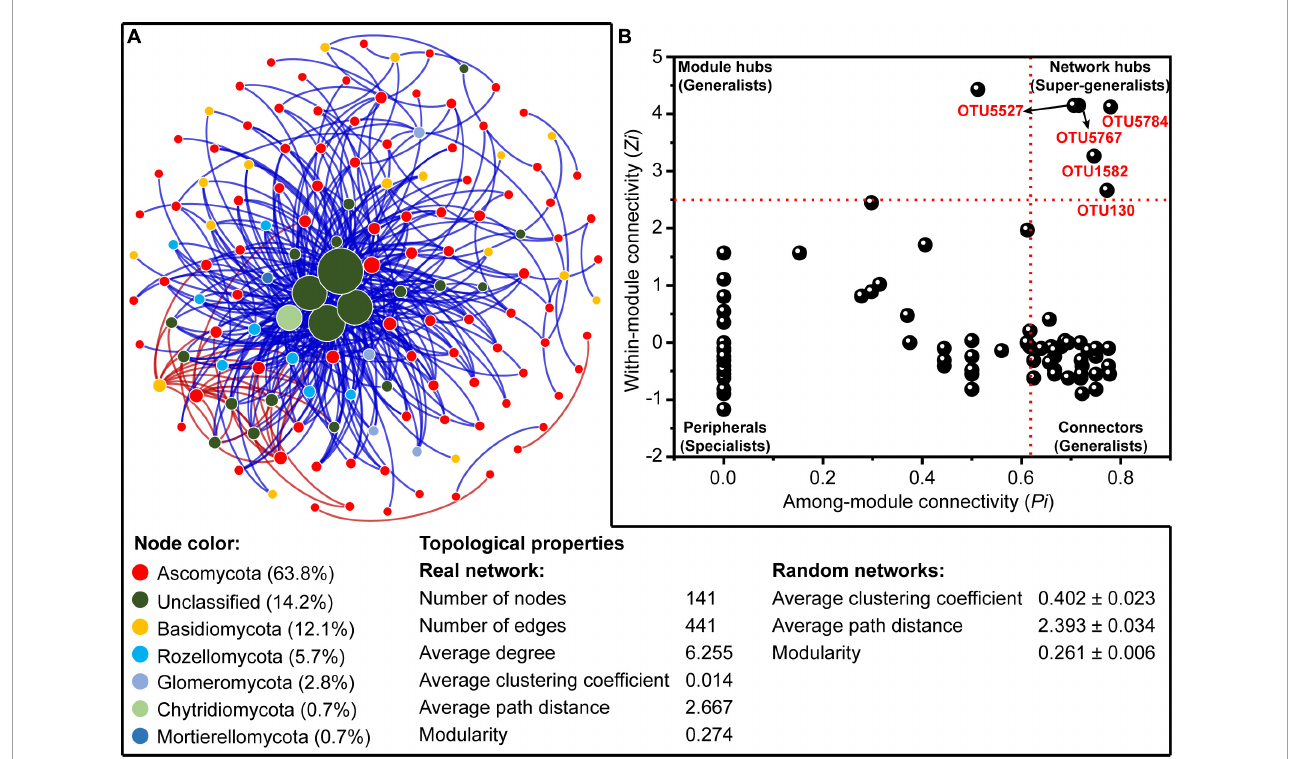
FIGURE5 (A) The co-occurrence network of rhizosphere fungal community at operational taxonomic unit (OTU) level based on random matrix theory (RMT). The nodes in the network represent OTUs, and the size of each node is proportional to the corresponding node degree (number of connections). The nodes are colored by fungal phylum. The red and blue lines, respectively, indicate positive and negative correlations between any two OTUs. (B) The Zi - Pi plot reveals the distribution of OTUs of rhizosphere fungal community based on the topological